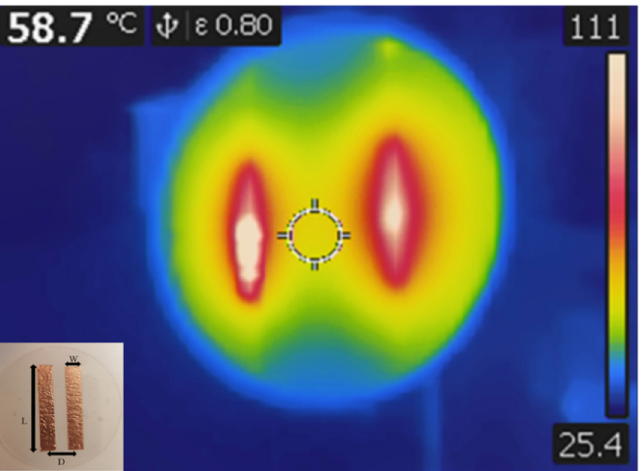
Figure 10. Captured laser image of thermal profile of double dipole pattern on VO 2 over sapphire wafer during heating. Inset: geometry of double dipoles showing the length, L, width, W, and spacing, D.